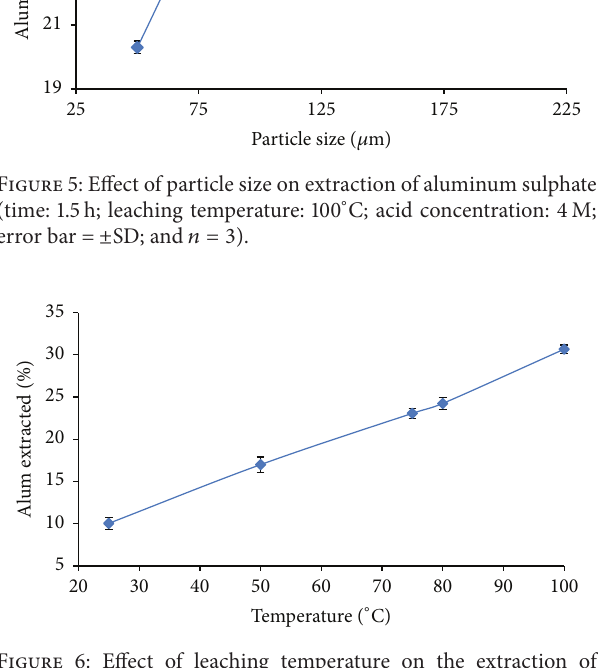
Figure 6: Effect of leaching temperature on the extraction of aluminum sulphate (particle size: 100 𝜇 m; leaching time: 1.5h; acid concentration: 4M; error bar = ± SD; and 𝑛 = 3 ).